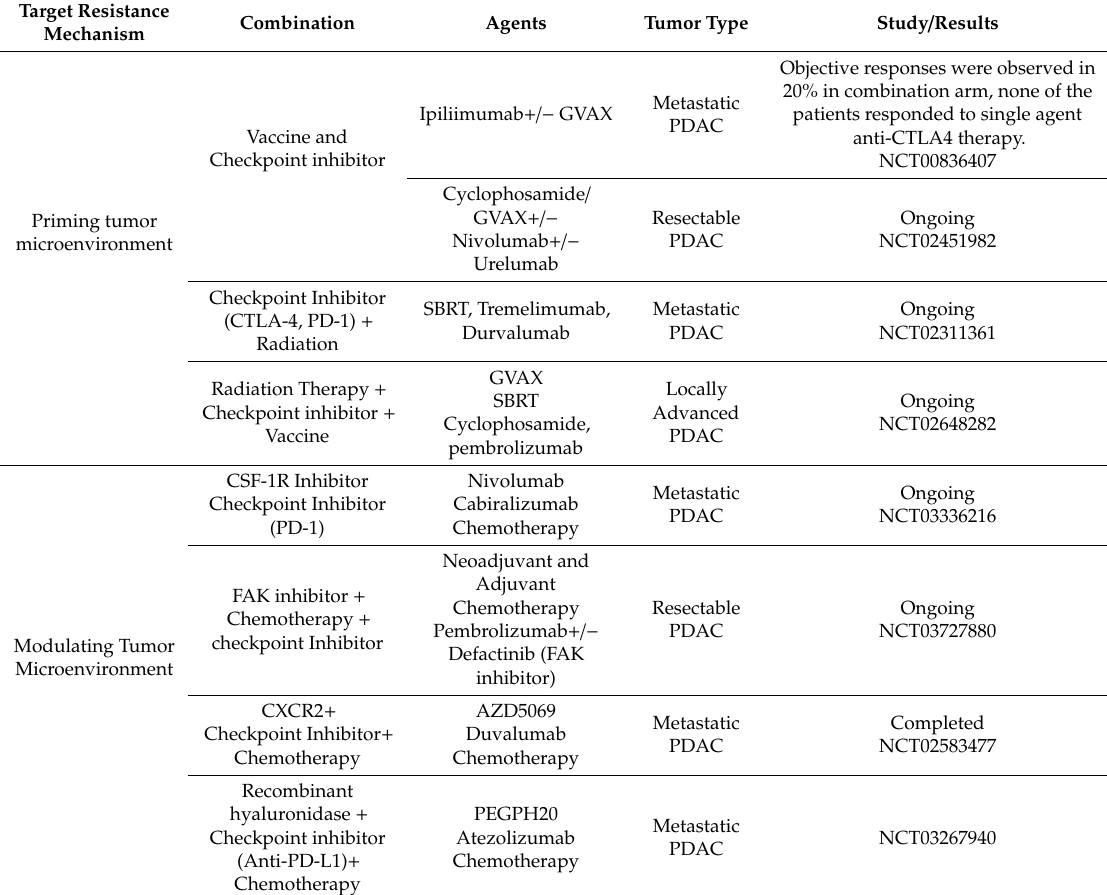
Table 1. Selected examples of completed and ongoing combination immunotherapy clinical trials /